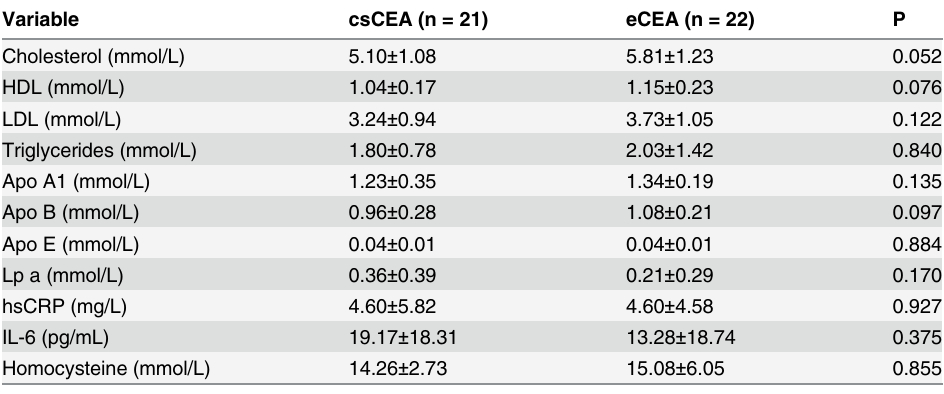
Table 2. Baseline biochemical characteristics of patients undergoing CEA.